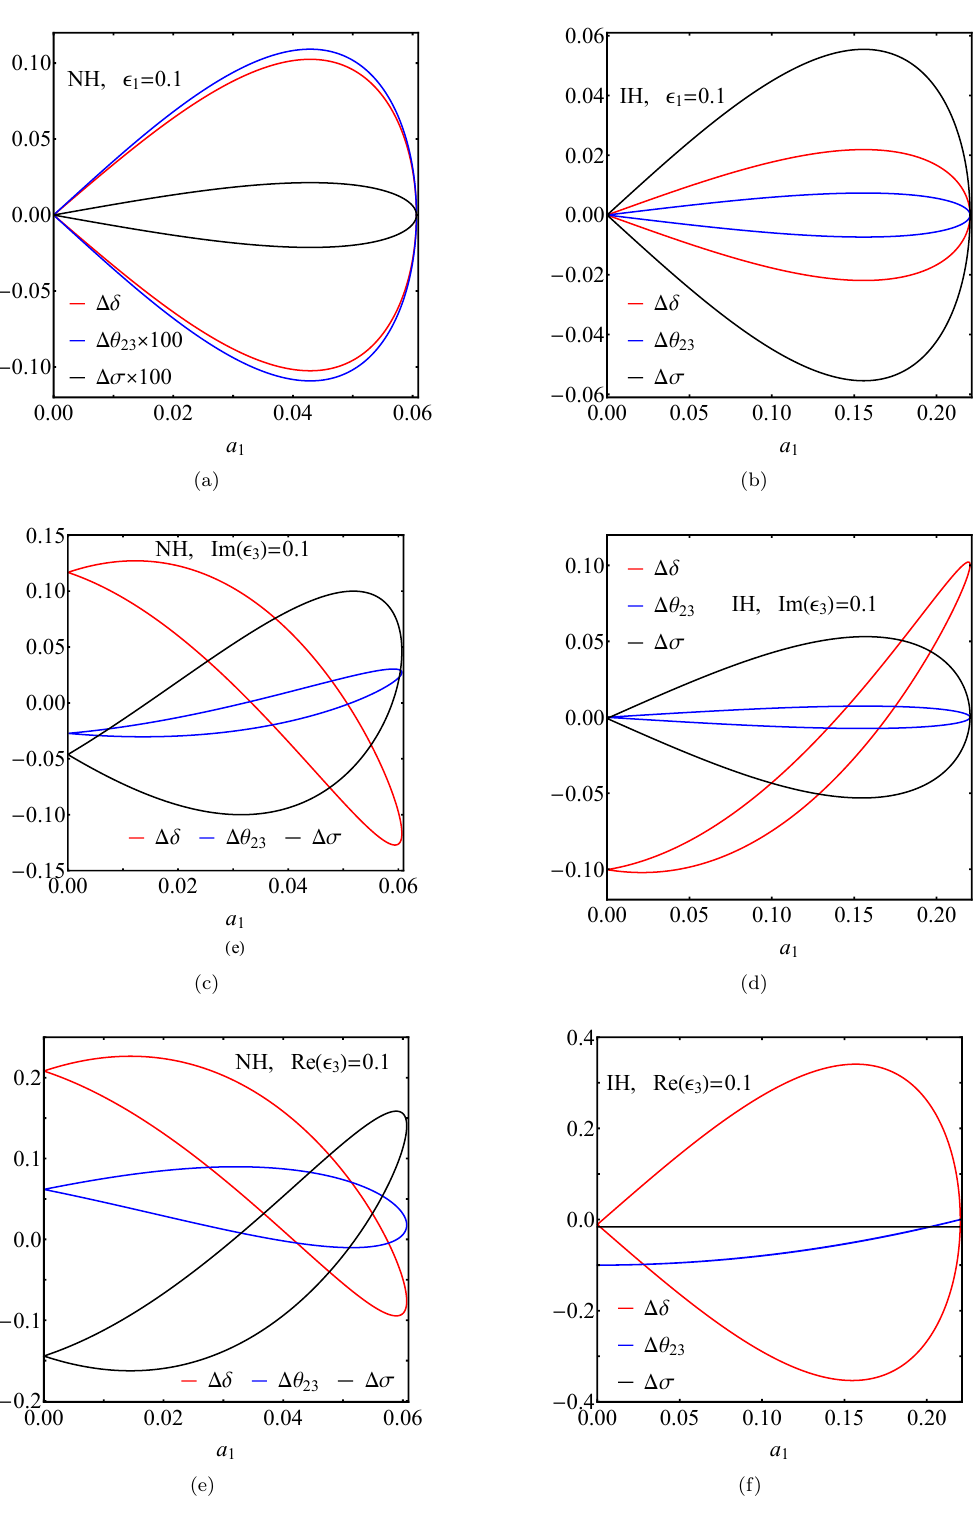
Figure 2 . The (cid:1) (cid:18) Im( (cid:15) ) = 0 : 1 in the NH and IH cases. 3